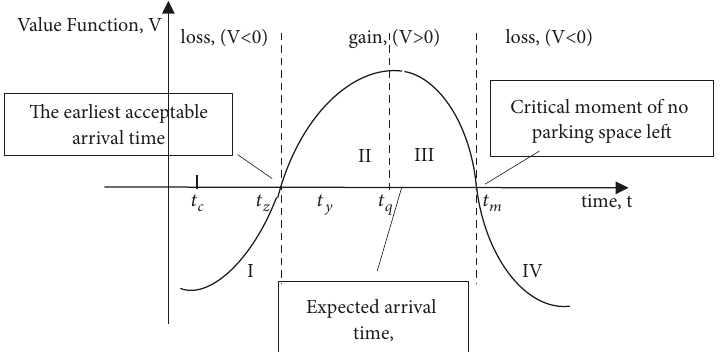
Figure 1: Value function of departure time